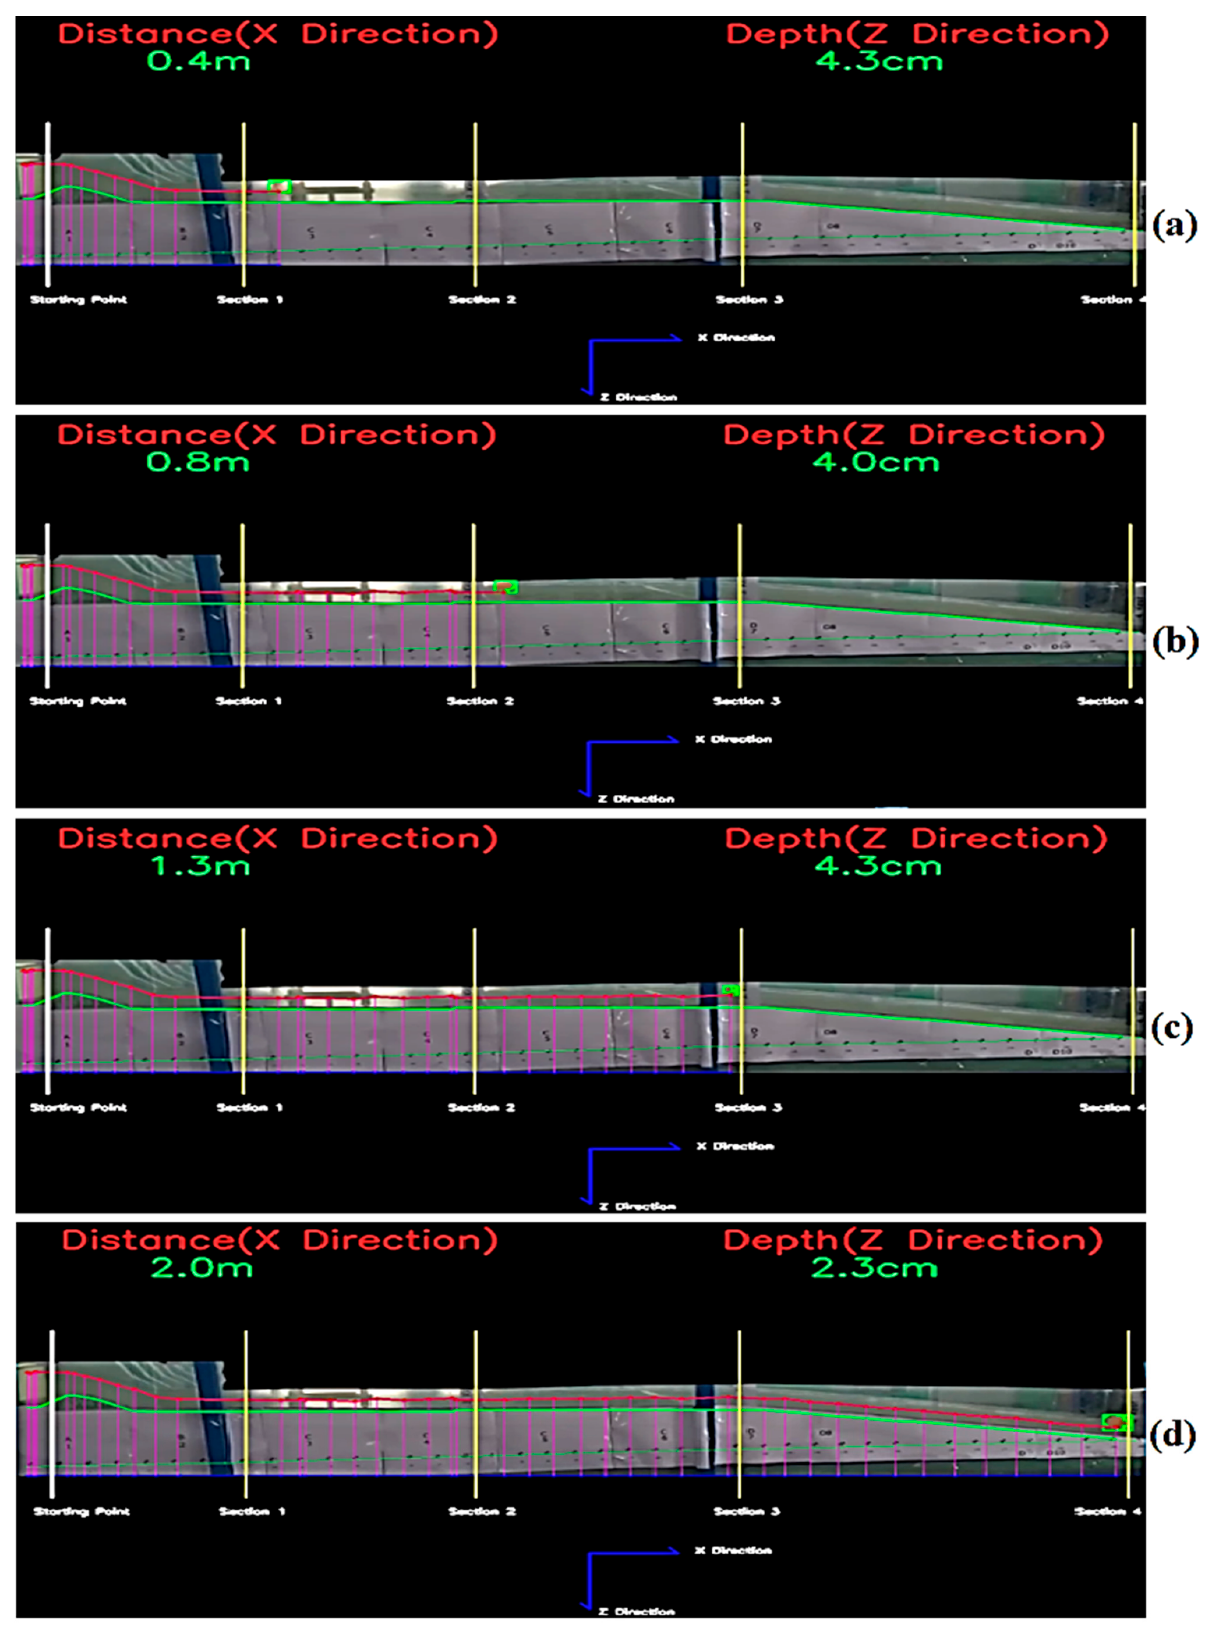
Figure 30. OpenCV code display of the water depth obtained according to the position of the floating object: ( a ) Cross-section 1; ( b ) Cross-section 2; ( c ) Cross-section 3; ( d ) Cross-section 4.